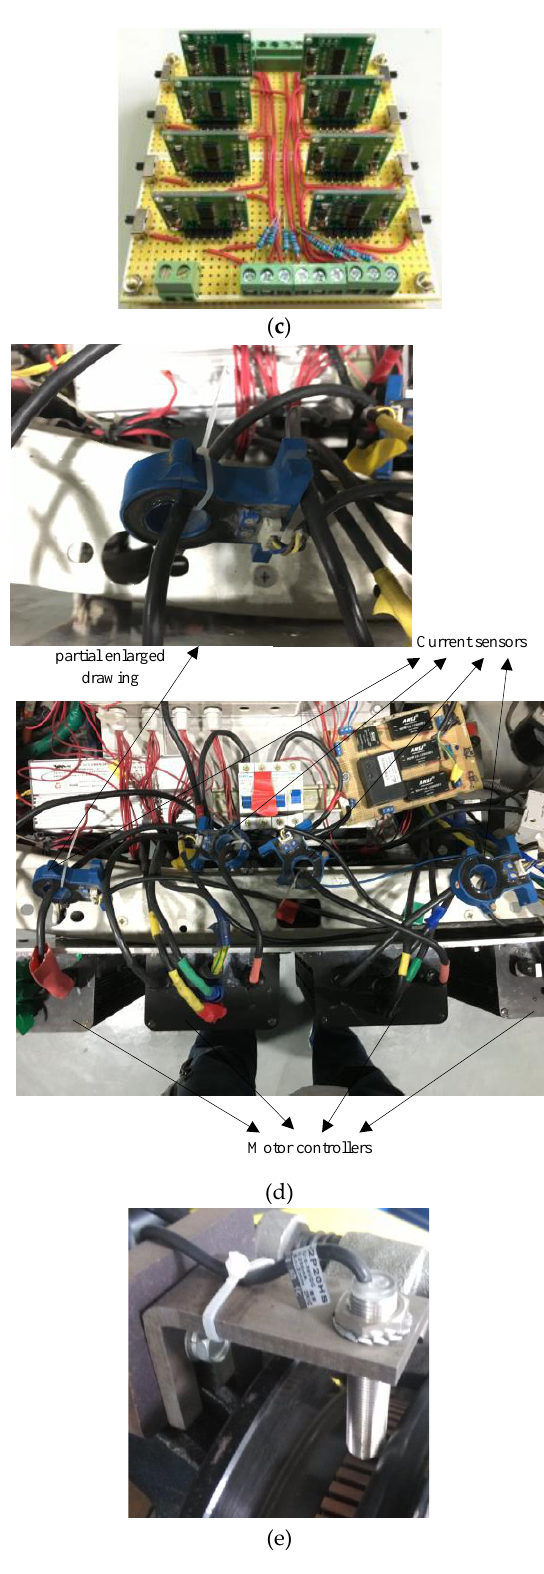
Figure 18. Control system and sensor network of 4WID-EV. ( a ) The electrical system of 4WID-EV; ( b ) Schematic diagram of sensor information collection; ( c ) D/A converter; ( d ) Current sensors; ( e ) Wheel speed sensors.